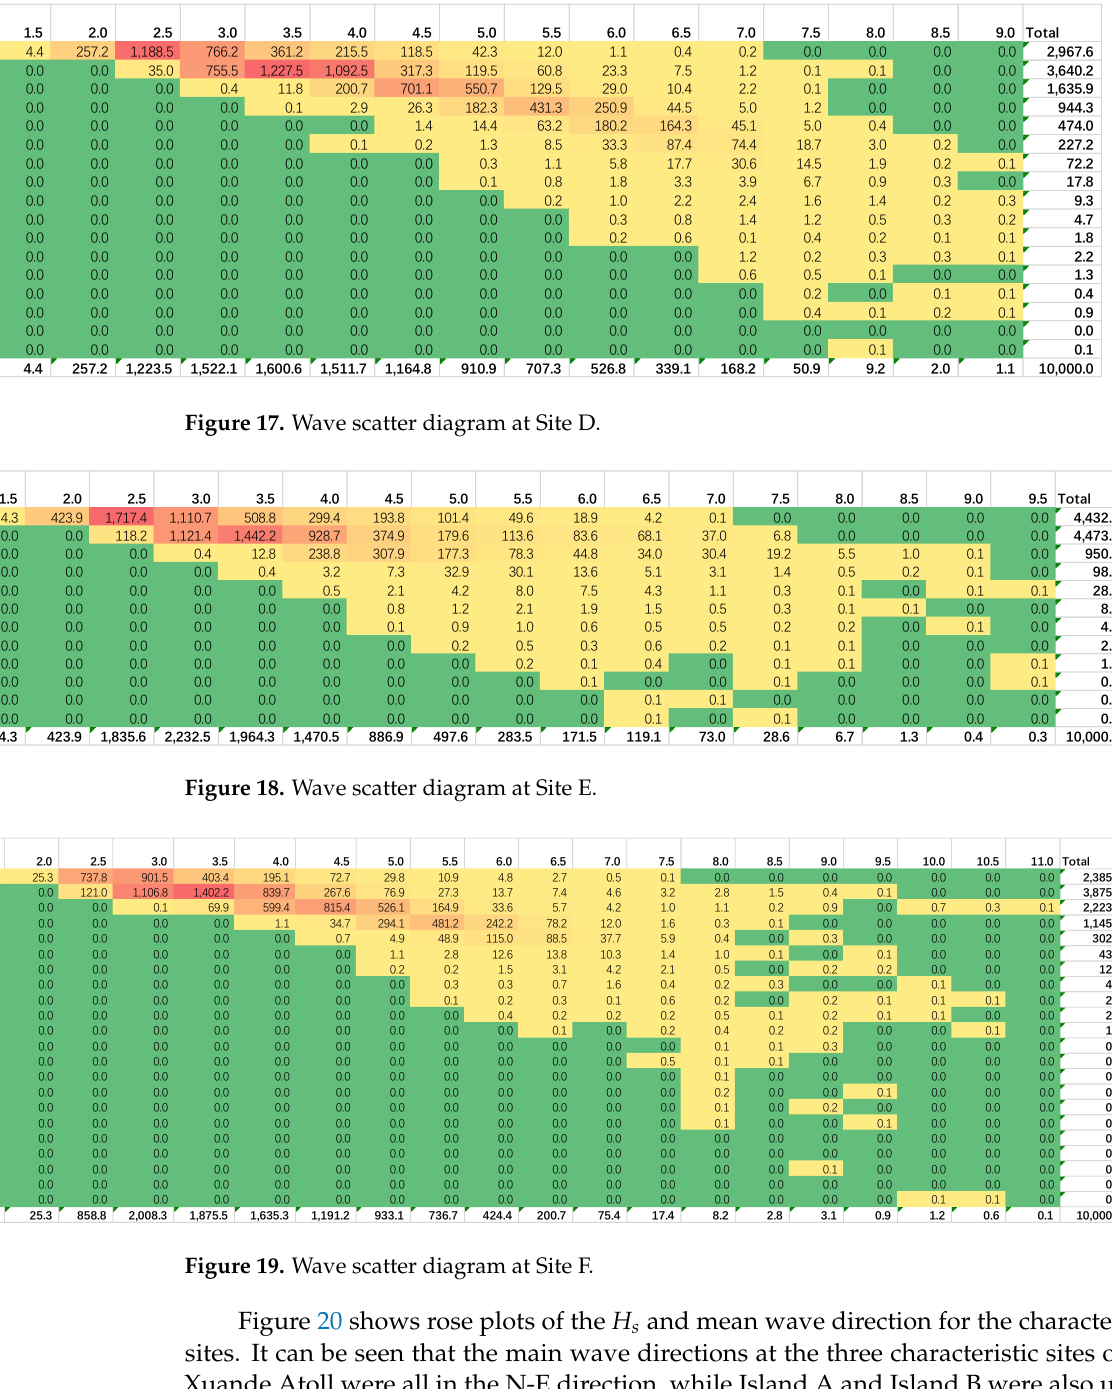
Figure 16. Wave scatter diagram at Site C.